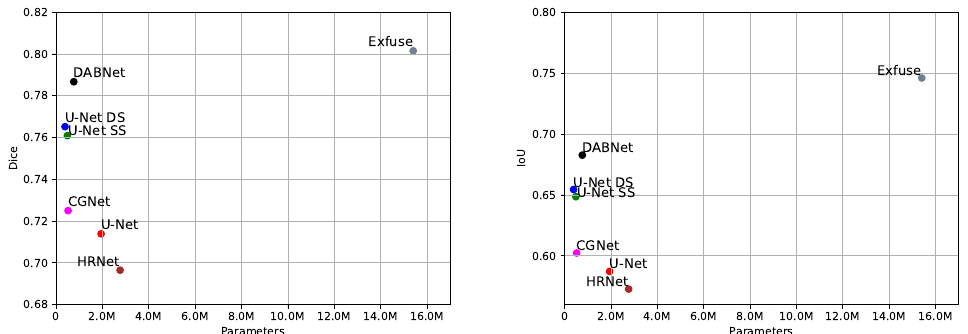
Figure 11. Comparison of the Dice and IoU scores vs. number of parameters.